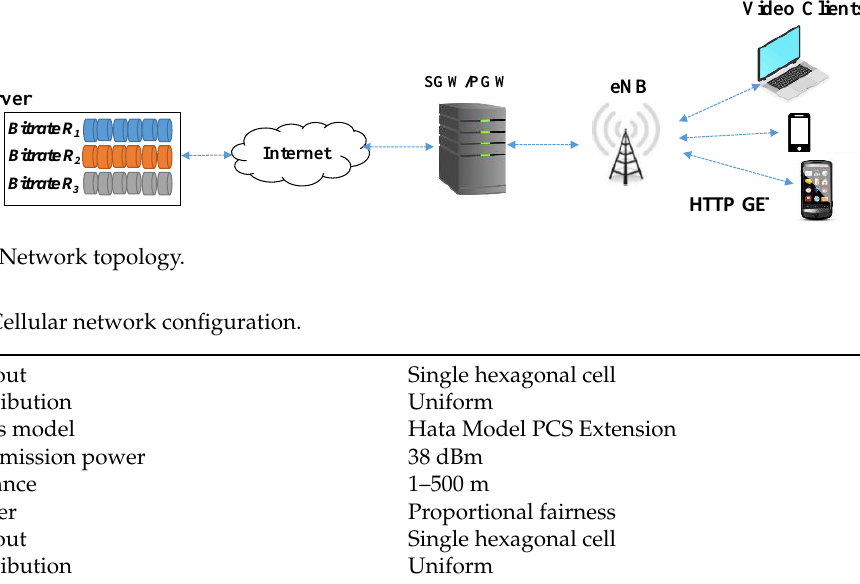
Table 3. Experiment settings used to analyze the performance of the algorithms.